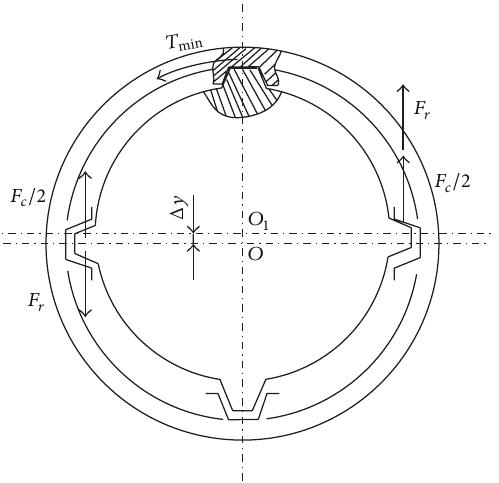
Figure 7: Axial force vector diagram.